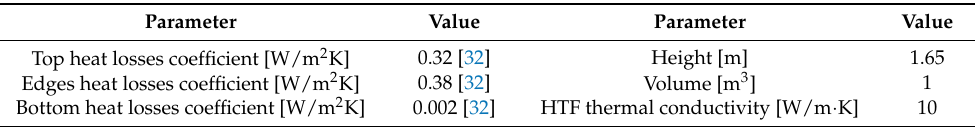
Table 2. Parameters of the stratified water tank used in the simulations.